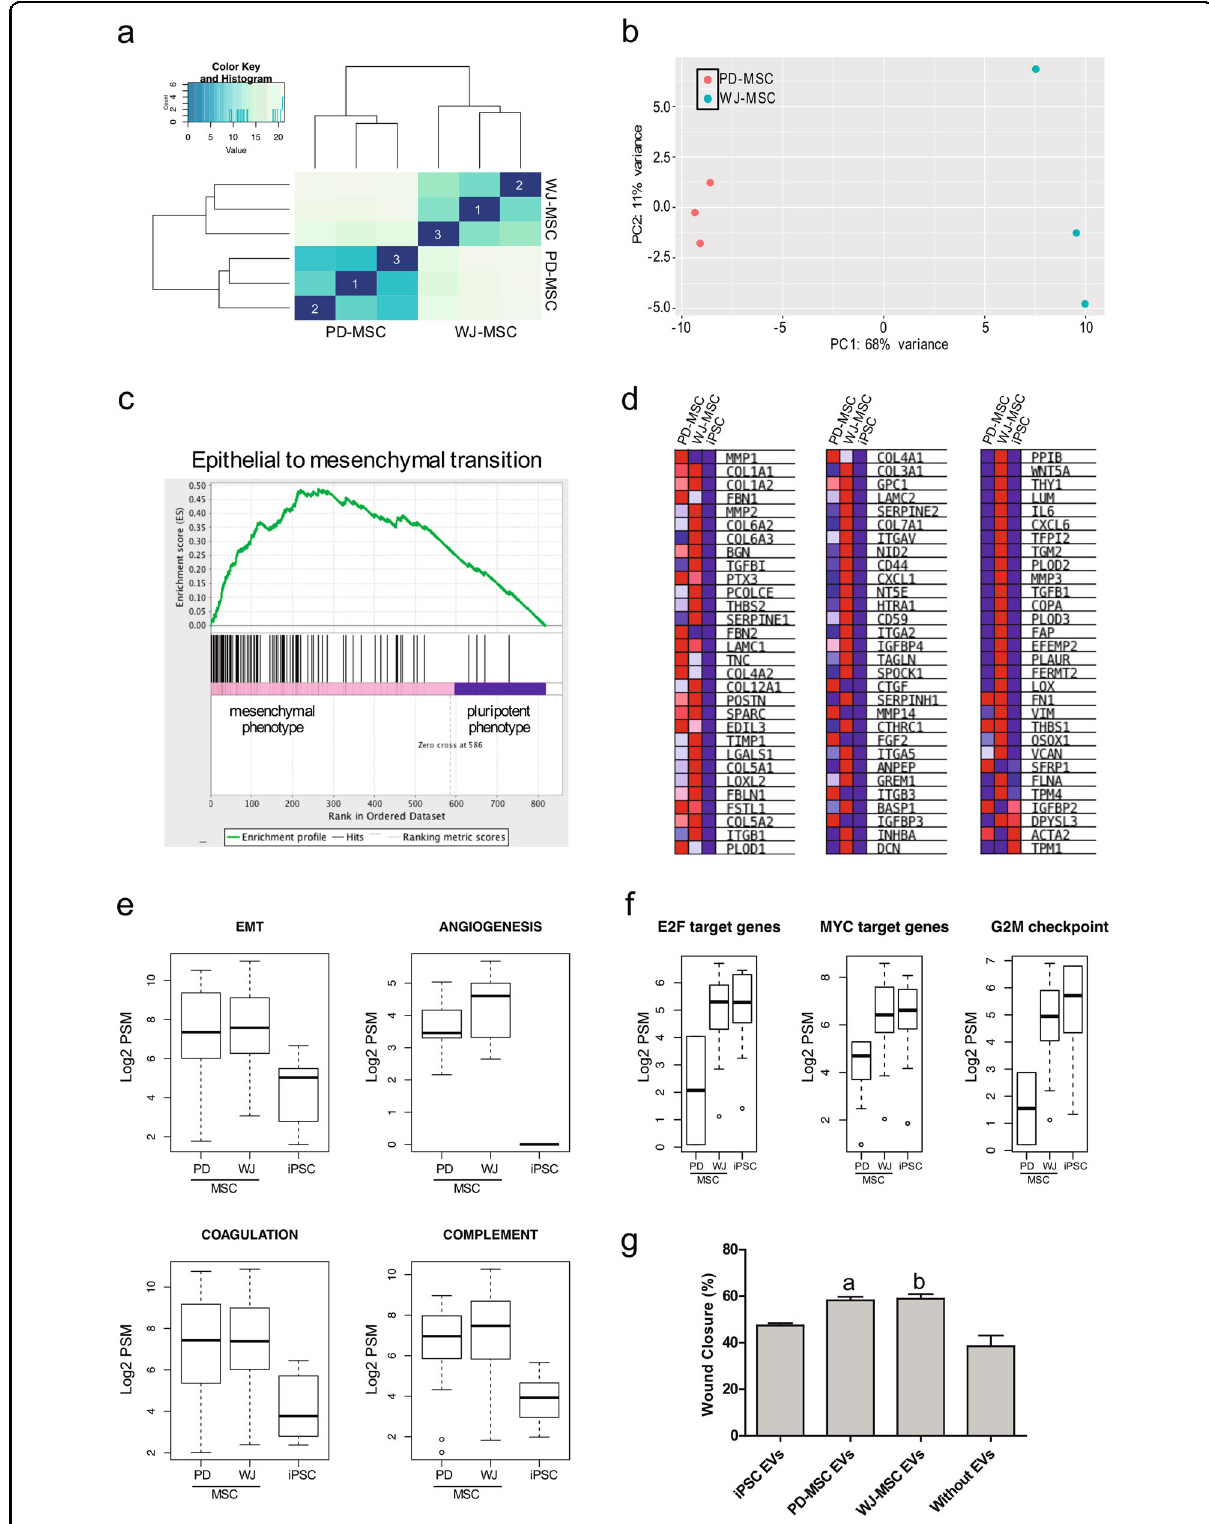
Fig. 5 (See legend on next